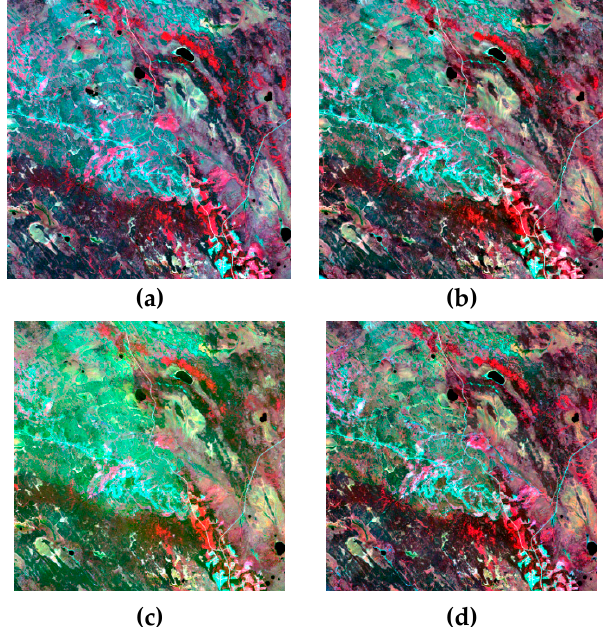
Figure 6. The ( a ) actual image acquired on 11 July 2001 and its predictions by ( b ) STBDF-II; ( c ) STARFM; and ( d ) ESTARFM. Table 3. Quantitative metrics of the fusion results applied to the Boreal images. AAD